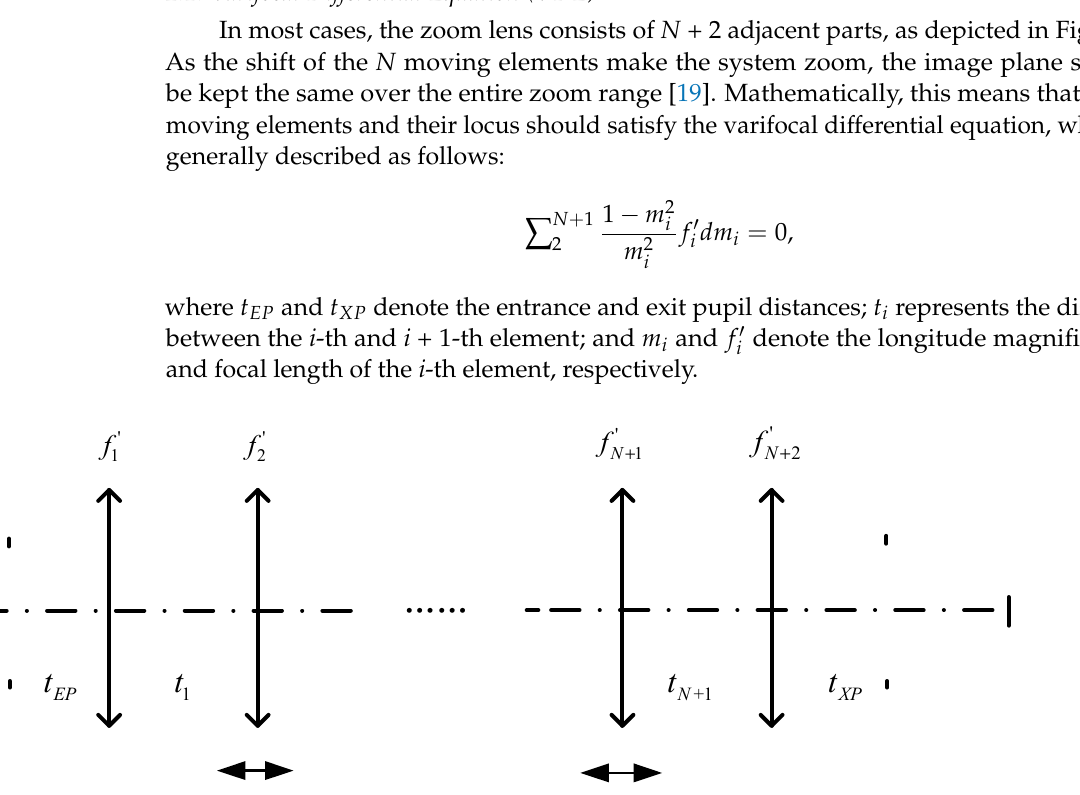
Figure 1. Schematics of the general zoom lens design model.